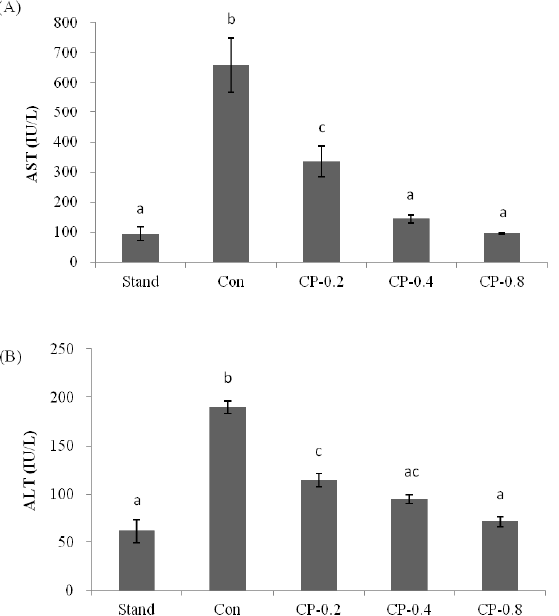
Figure 3. The effects of CPs on transaminase activities in mice serum at 12 h after ethanol treatment. ( A ) The level of AST. ( B ) The level of ALT. Values are expressed as means ± SEM ( n = 5 – 10). Values with different letters are significantly different ( p < 0.05).